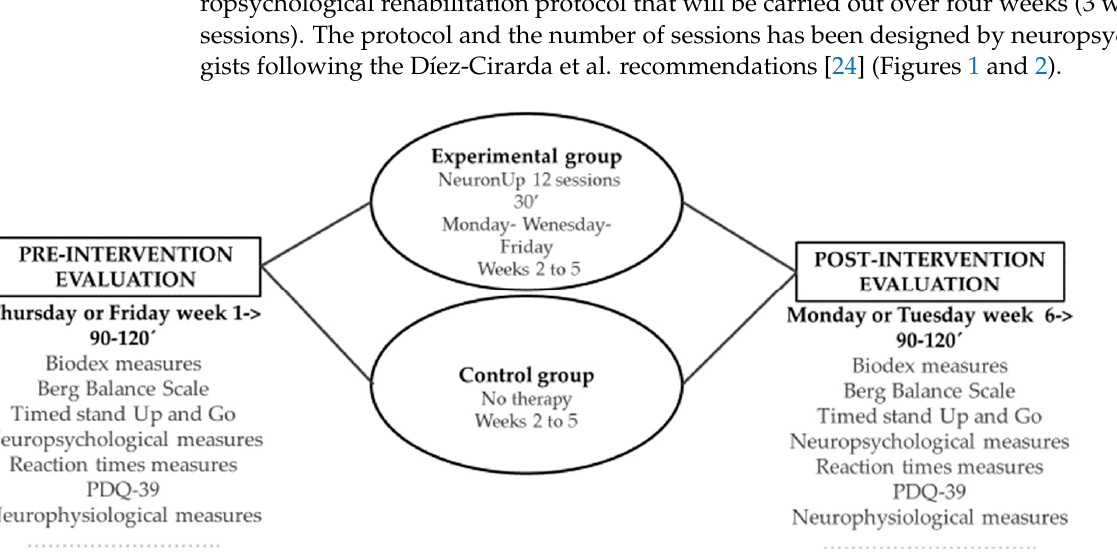
Figure 2. Schematic representation of the study experimental procedures.